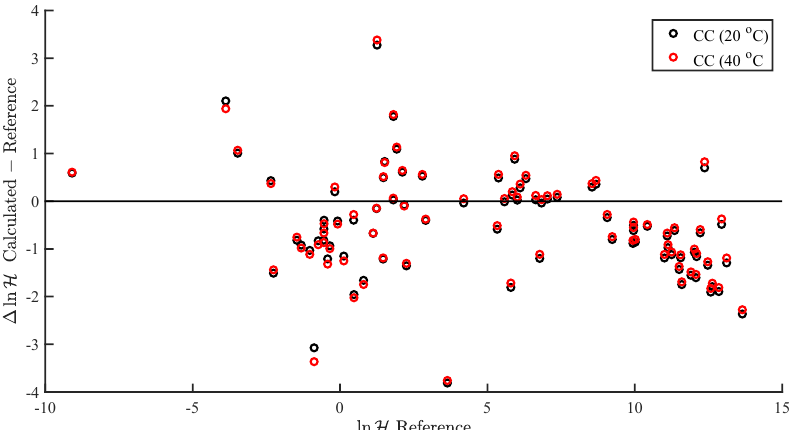
Figure 5. Residual plot of the difference between the reference and calculated log Henry’s constant (ln H 2,1 , Equation (3)) for organic solutes in water, versus the reference values. H 2,1 is in units of bar. The solid line corresponds to the y = 0 line and is drawn as a reference. Predictions were made for MOSCED with ln P sat computed using the Clausius–Clapeyron equation with a reference 2 temperature of 20 and 40 ◦ C, as